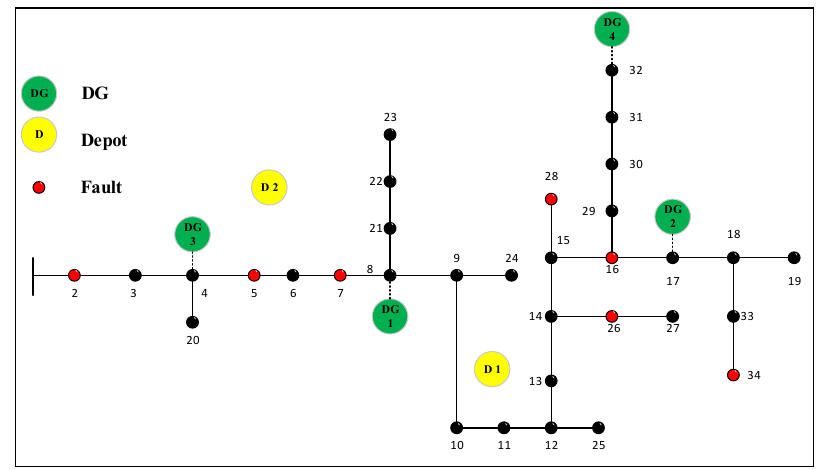
Figure 3. IEEE 34 bus test system.